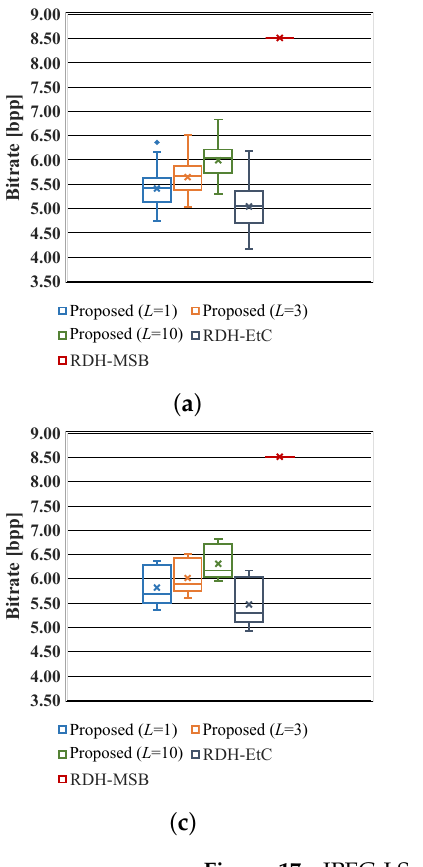
Figure 17. JPEG-LS compression performance of proposed, RDH-EtC [30] and RDH-MSB [29] methods. ( a ) Kodim4; ( b ) peppar; ( c ) ihc5 (1/16); ( d ) ihc5 (original).